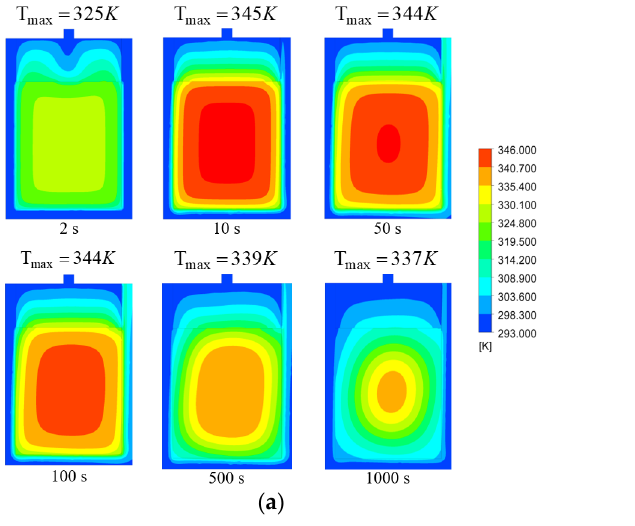
Figure 5. Temperature and hydrogen storage capacity distribution at different times inside the reaction tank, subjected to a cooling water flow rate of 0.005 m/s. ( a ) Temperature distribution cloud chart; ( b ) Hydrogen storage capacity distribution cloud chart.